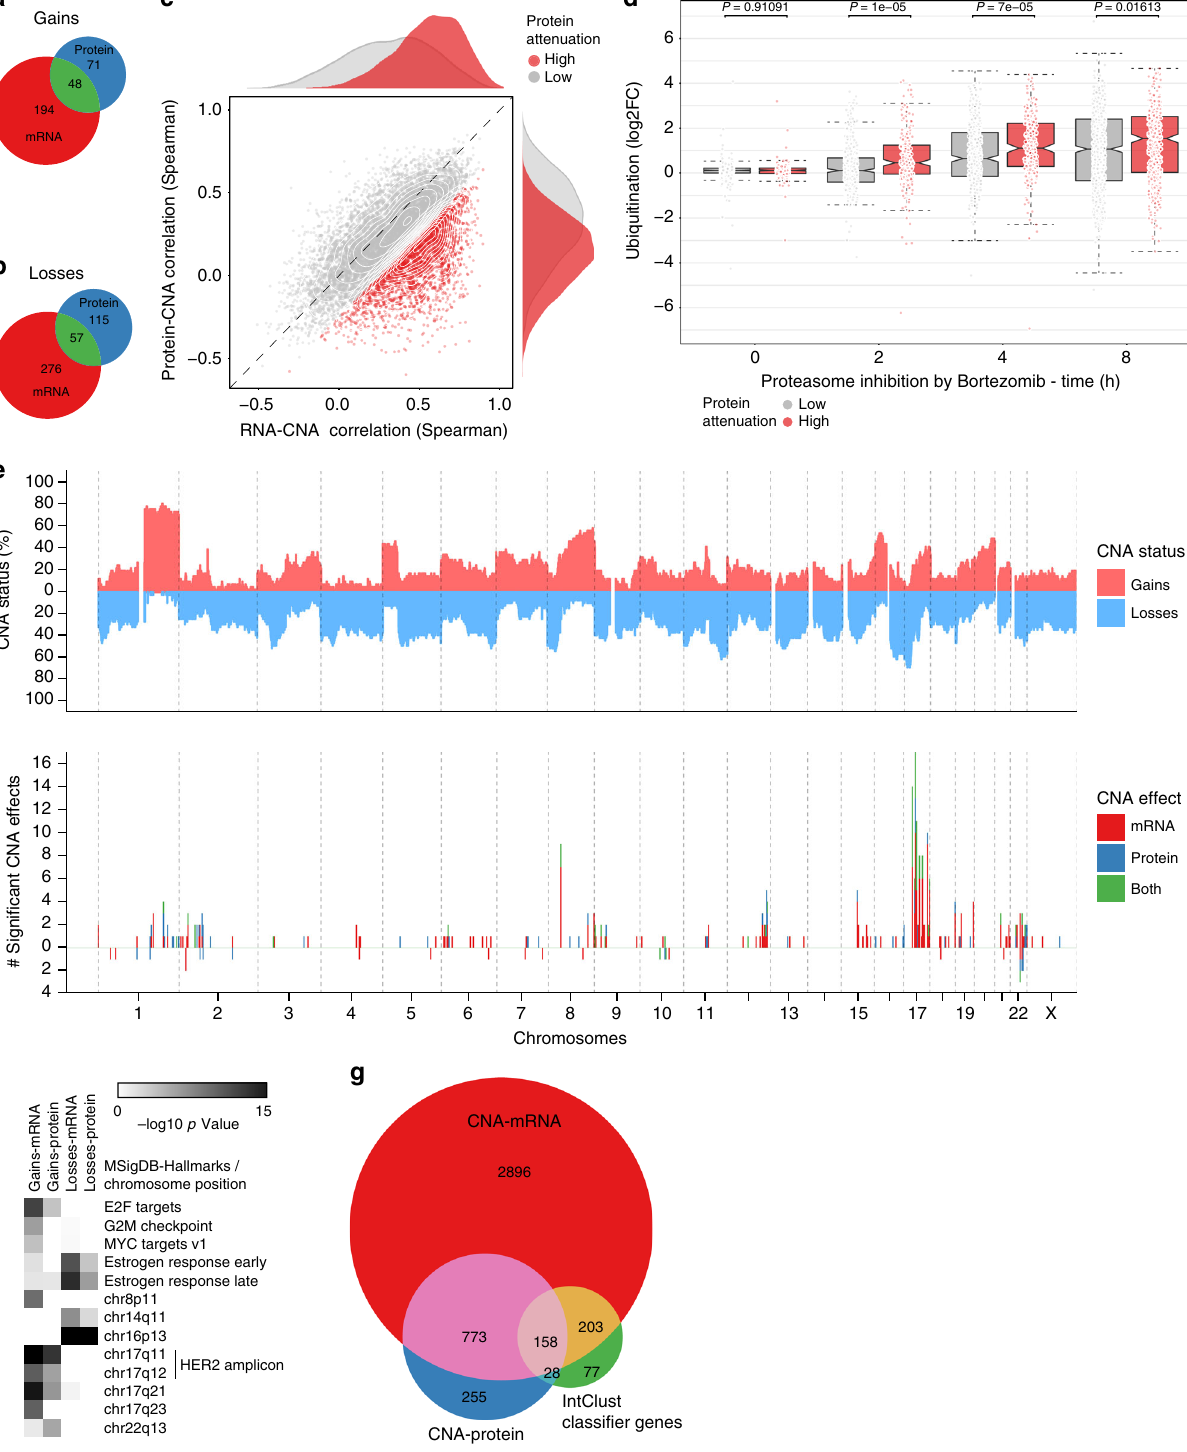
Fig. 6 Gene copy number effects on mRNA and protein levels. a , b Venn diagrams displaying CNAs associated with mRNA and/or protein levels for a gains and b losses in cis . See Supplementary Fig. 13 and Supplementary Methods for de fi ning the CNA – mRNA/protein associations. c Scatter plot of CNA correlation to RNA and protein to identify CNA effects attenuated at the protein level. Attenuated proteins (in red) were identi fi ed using a Gaussian mixture model. d Boxplot of ubiquitinylation site fold change following bortezomib proteasome inhibition for proteins de fi ned as attenuated in panel c (red) compared with non-attenuated (gray). Wilcoxon test was used on the ubiquitinylation data from Kim et al. 27 . e Genomic distribution of CNAs and CNA effects of gains from a . f MsigDB and chromosome position enrichment analysis of CNA effects on mRNA and protein from a and b . Hypergeometric test. g Overlap of CNA effects to IntClust classi fi er genes (466 of 619 genes overlapped all three datasets) 30 . CNA effects associated with ANOVA as in Curtis et al.